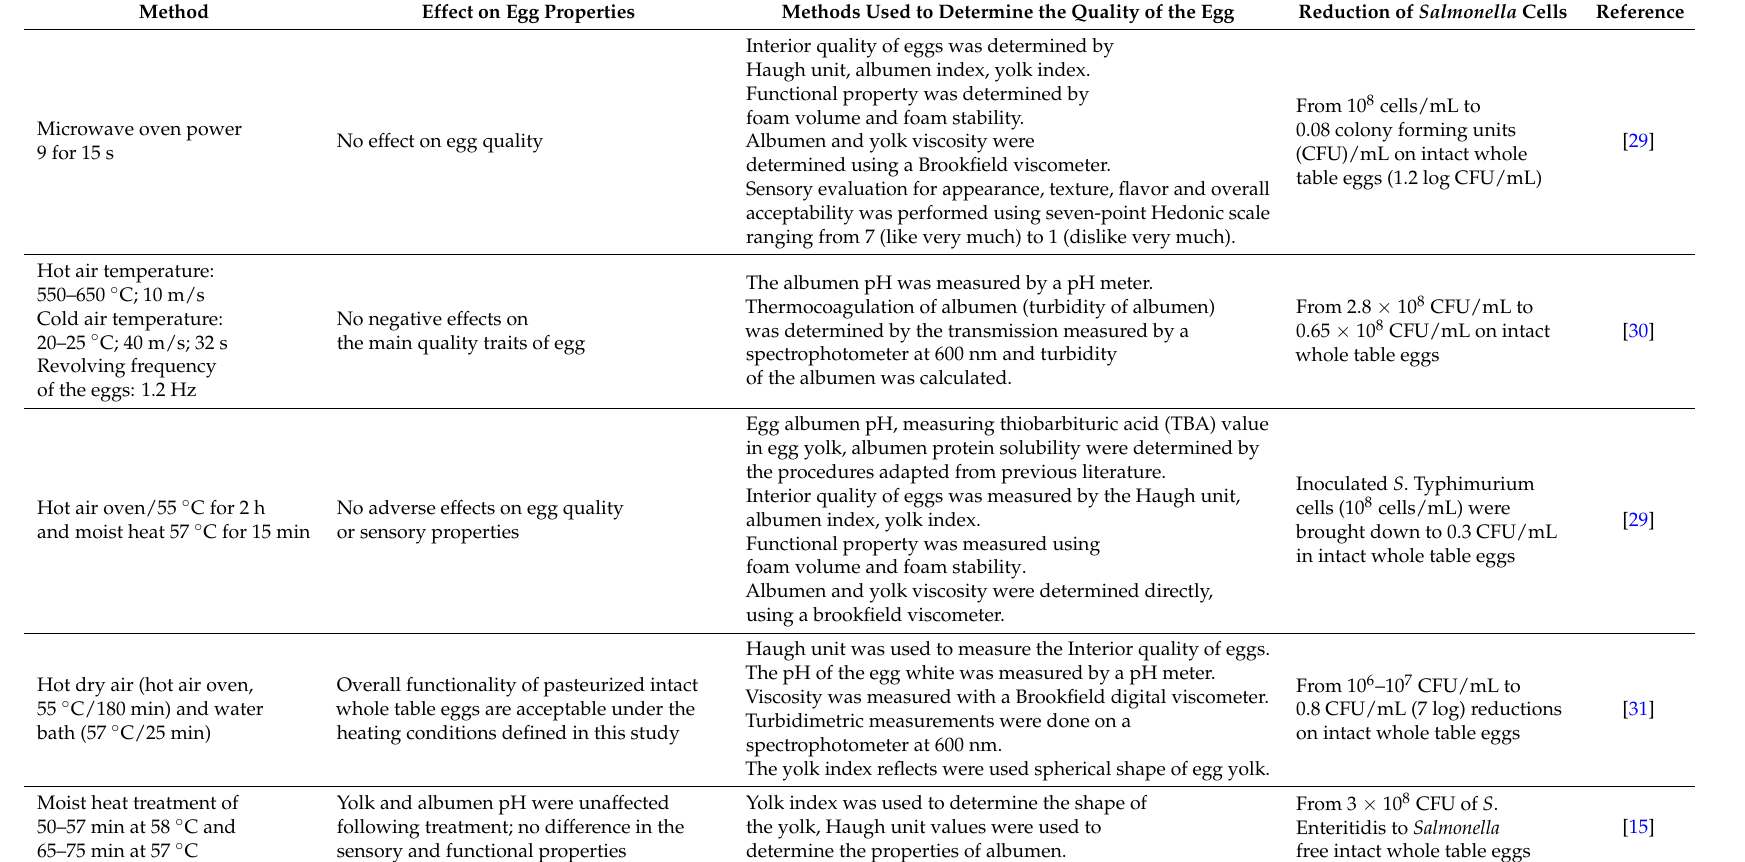
Table 1. The effect of the pasteurization and decontamination methods and the effect of the method on Salmonella